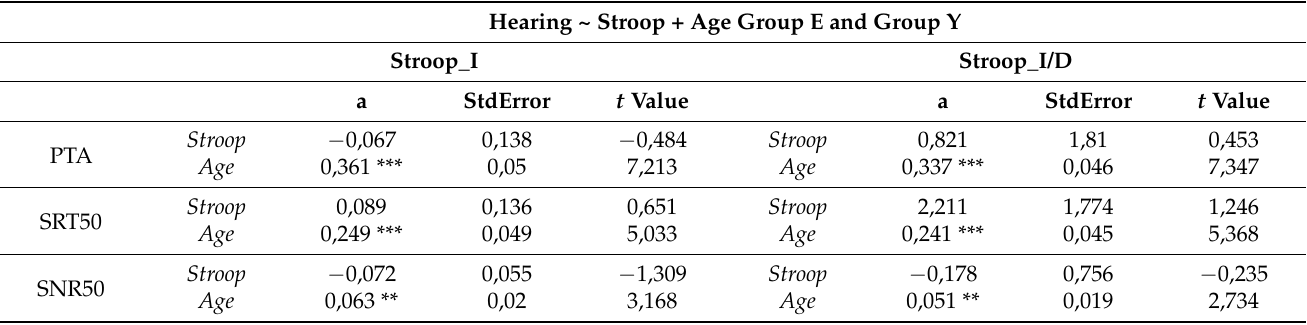
Table 3. Multiple regressions: hearing results as a function of Stroop scores and age.